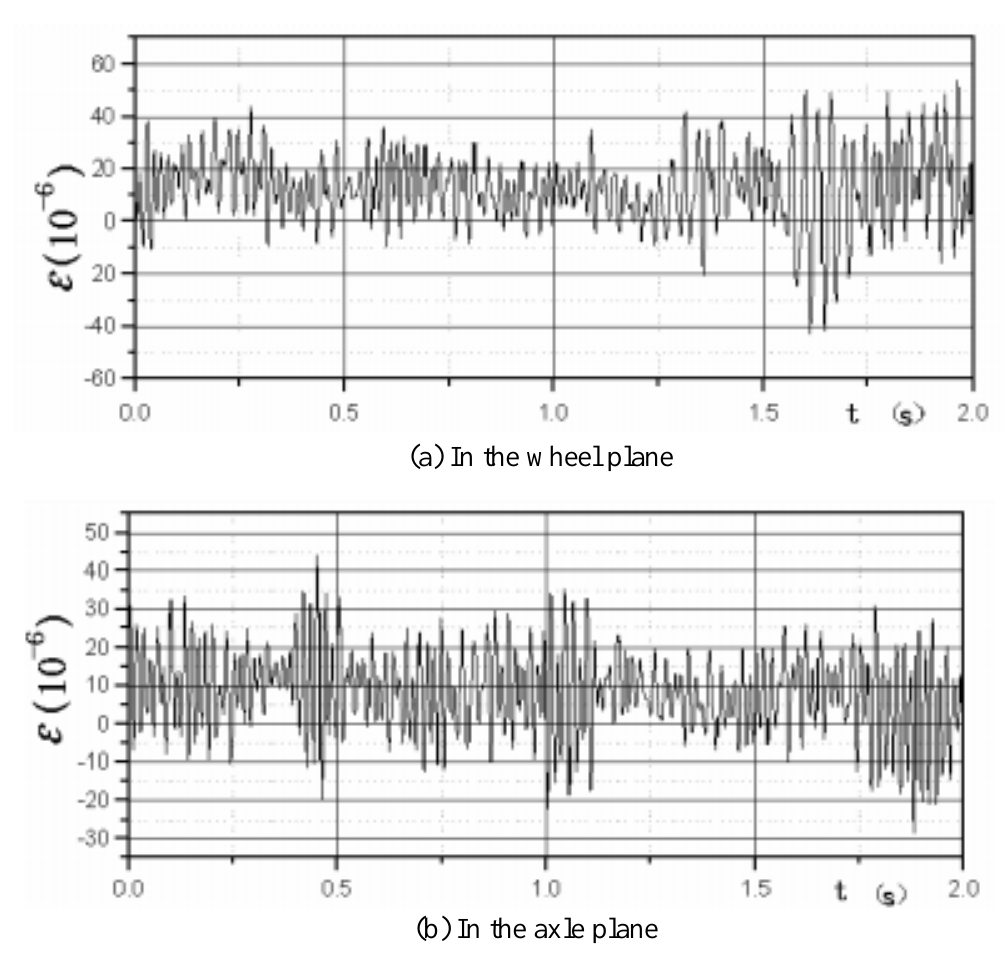
Fig. 8. (a) In the wheel plane (b) In the axle plane Real time responses of strains for the rear piston rod on uneven road at the speed of 80